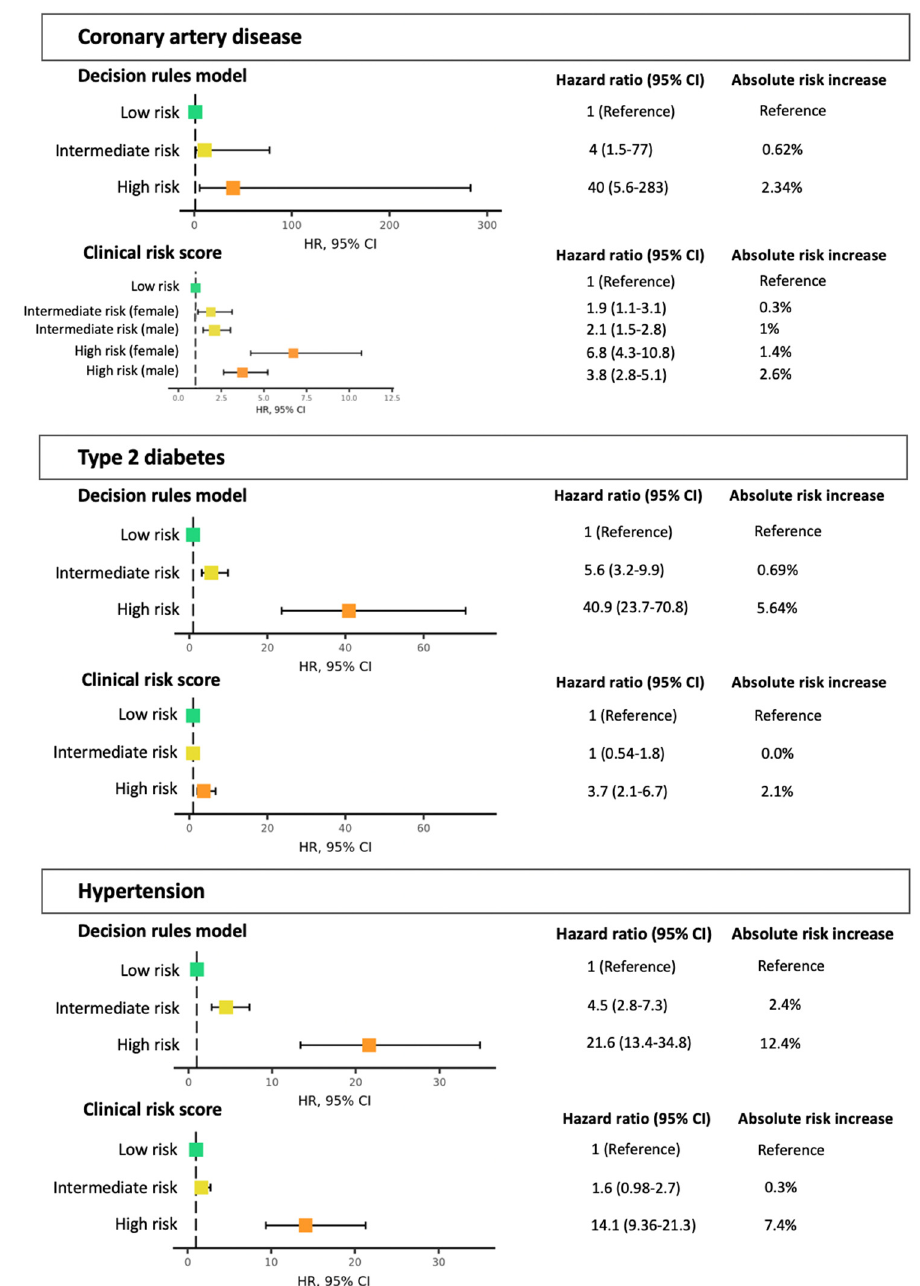
Figure 3. Hazard ratios (HR) of disease incidence per risk stratum. The group with no risk factors is used as reference. Both the HR and the absolute risk are displayed for each decision rules model and clinical score for all.